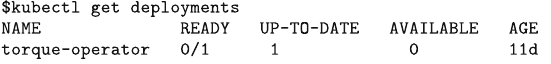
Kubernetes as its container orchestrator. Its architecture is illustrated in Fig. 4 on the left. For simplicity, Fig. 4